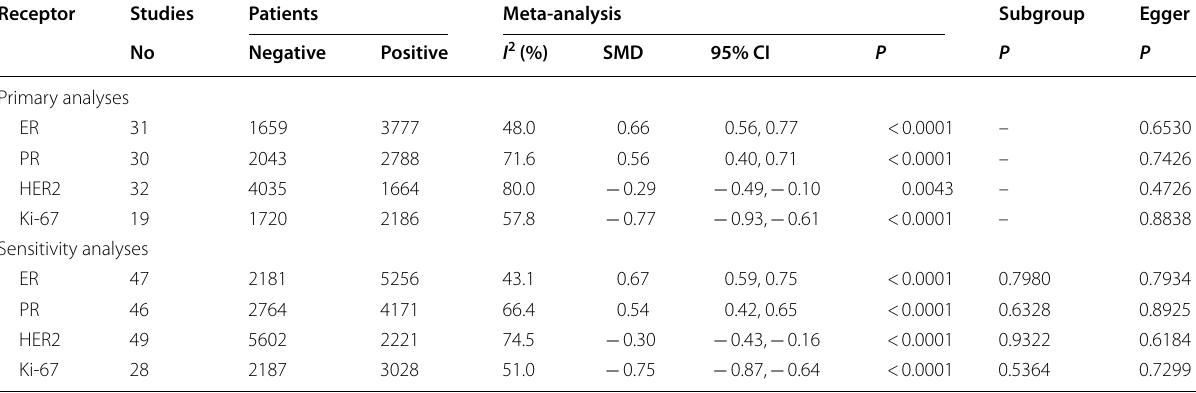
Data derived from the primary and sensitivity analyses are presented CI, confidence interval; ER, estrogen receptor; HER2, human epidermal growth factor 2 receptor; PR, progesterone receptor; SMD, standardized mean difference